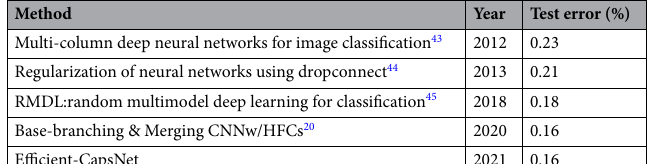
Method Year Test error (%) Multi-column deep neural networks for image classification